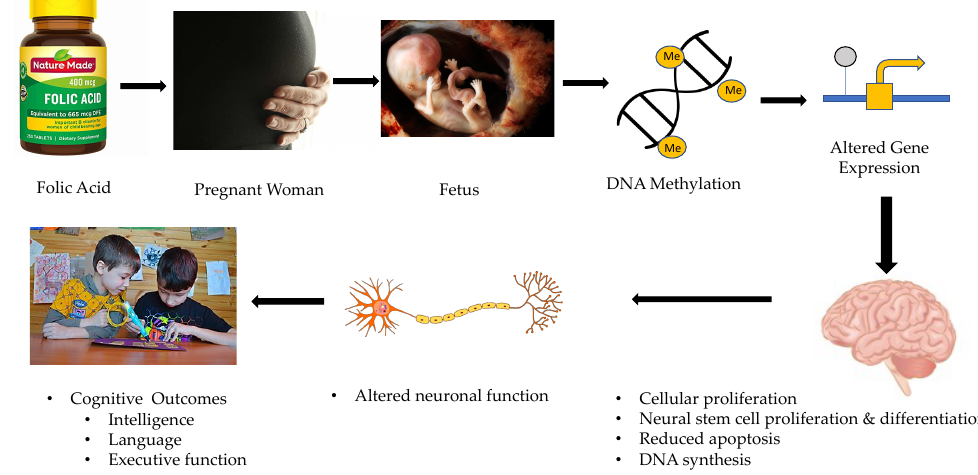
Figure 1. Potential mechanism of action through which prenatal folate affects brain and cognitive outcomes in